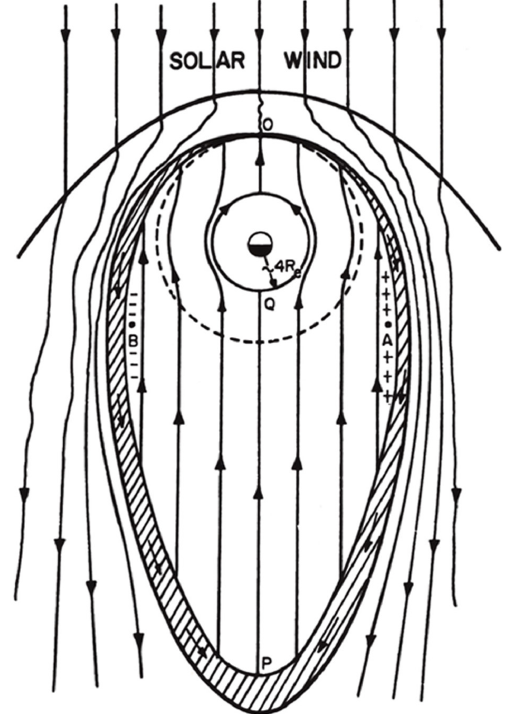
Fig. 9a. The magnetospheric dynamo produces a large convection of magnetospheric plasma and two eddy currents in the ionosphere, which are shown in Fig. 9b (Axford and Hines,